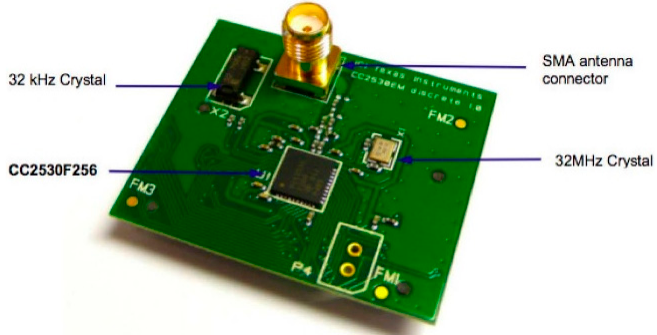
Figure 11. CC2530OEM module [Source: TI.com].